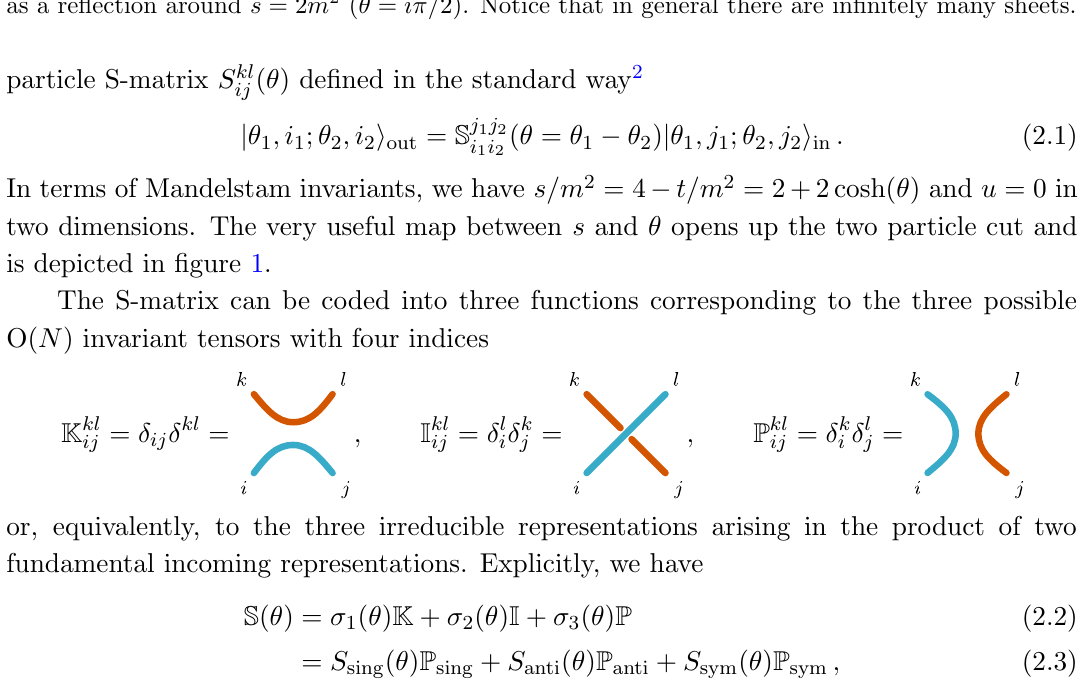
Figure 1 . Mapping between s and (cid:18) variables. The cuts corresponding to the two particle thresh- olds with branch points at s = 0 and s = 4 m 2 get opened in the (cid:18) plane. These cuts are square roots, so that going twice around one of the branch points leaves you back where you began. This is exempli(cid:12)ed in the red path for the branch point s = 4 m 2 (or the regular point (cid:18) = 0). The thick lines in black represent possible inelastic thresholds. Unitarity is imposed for physical values of the center of mass energy s (cid:21) 4 m 2 ( (cid:18) > 0) represented by the green dashed line. The phys- ical sheet(strip) in s ( (cid:18) ) is highlighted in grey. The bound state poles are located in the window (cid:2) (cid:3) s 2 0 ; 4 m 2 ( (cid:18) 2 [0 ; i(cid:25) ]) (blue line). Finally, the points in yellow are related by crossing which acts as a re(cid:13)ection around s = 2 m 2 ( (cid:18) = i(cid:25)= 2). Notice that in general there are in(cid:12)nitely many